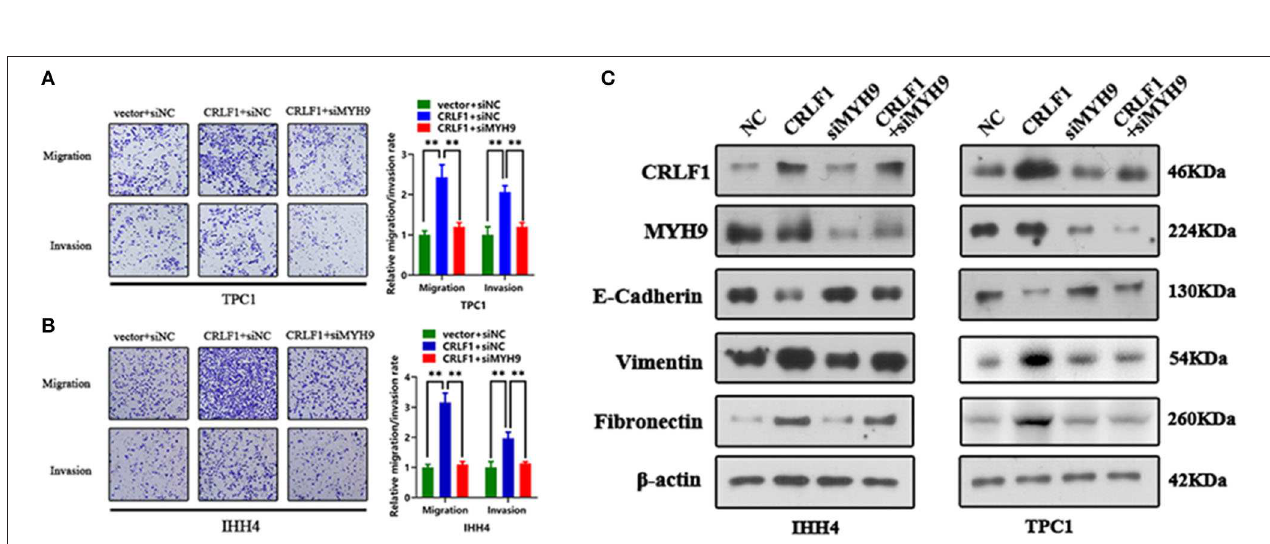
FIGURE 3 | Impact of MYH9 knockdown on the effects of CRLF1 on the migration, invasion, and EMT process of PTC cells. (A) Representative images showing the migrating/invading TPC1 cells expressing the vector or CRLF1 plasmid, which were then transfected with siNC or siMYH9. The histograms show the mean ± SD of the number of migrating/invading cells from three independent assays. (B) Representative images showing the migrating/invading IHH4 cells expressing the vector or CRLF1 plasmid, which were then transfected with siNC or siMYH9. The histograms show the mean ± SD of the number of migrating/invading cells from three independent assays. (C) Protein levels of EMT markers that changed following CRLF1 knockdown in PTC cell lines overexpressing CRLF1. β -Actin served as the loading control. Significant differences are indicated as follows: ** P < 0.01.